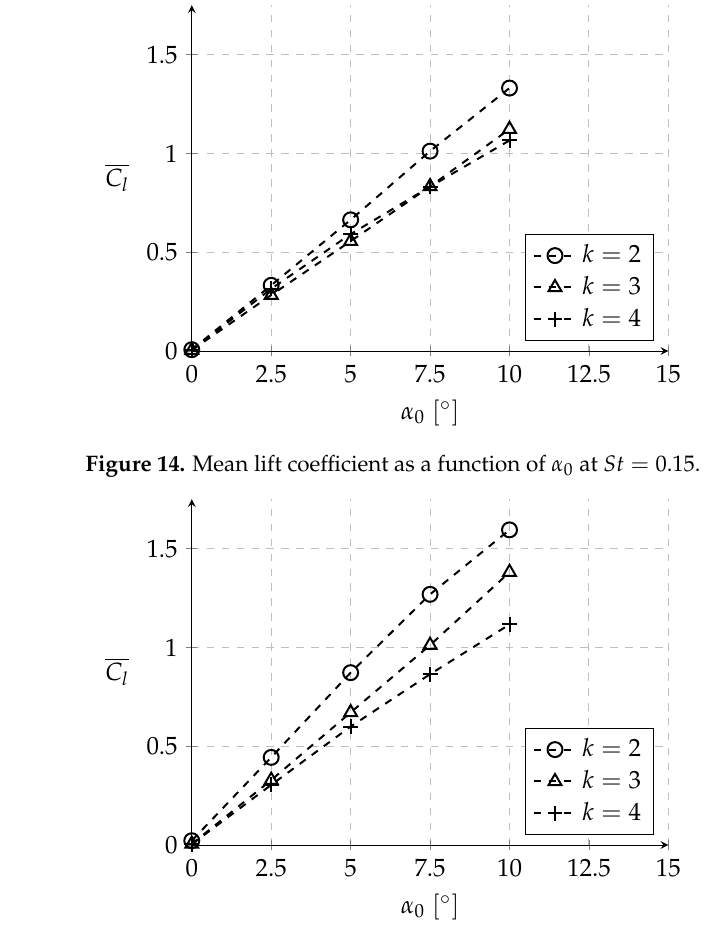
Figure 15. Mean lift coefficient as a function of α 0 at St =